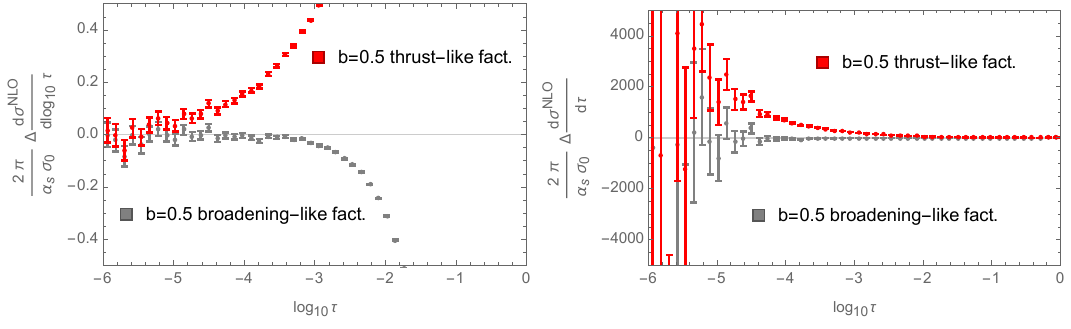
Figure 6 . Differences between Event2 and our one-loop predictions from SCET for d σ/ d τ for b = 0 and b = 0 . 2. The insets magnify the region of larger values of τ . −